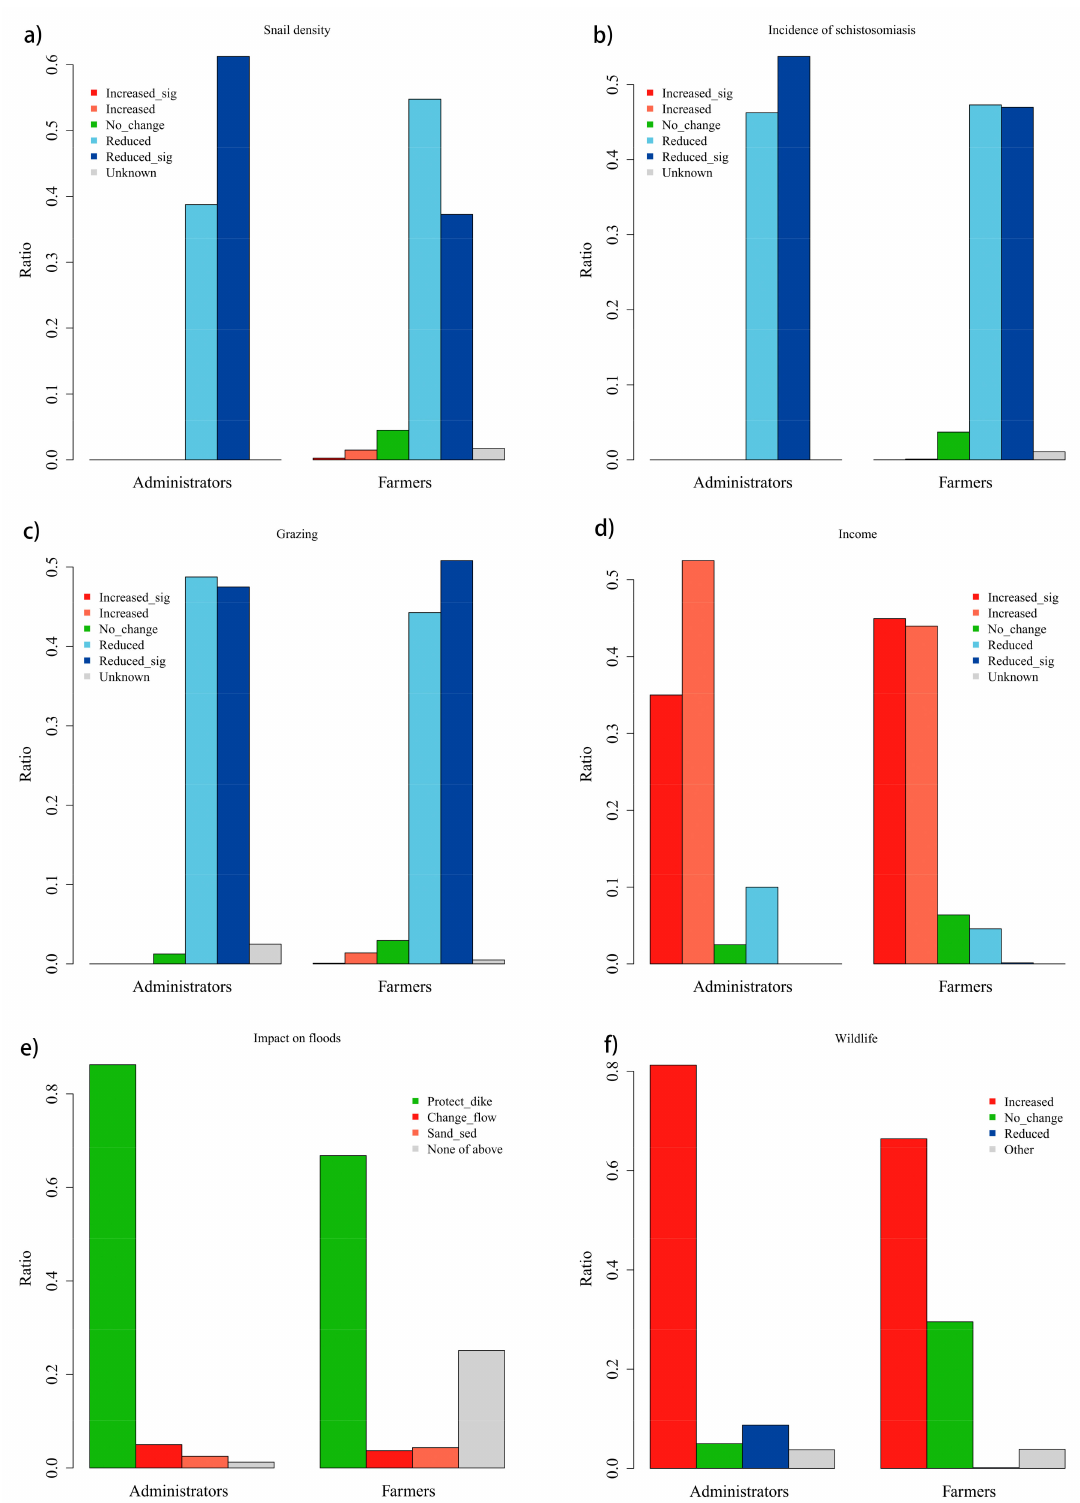
Figure 2. Views on the e ff ectiveness of the planting program. ( a ) Impacts on snail densities, ( b ) Impacts on incidences of schistosomiasis, ( c ) Impacts on grazing, ( d ) Impacts on farmers’ income, ( e ) Impacts on floods, and ( f ) Impacts on wildlife. The abbreviations are sig = significantly, sed =